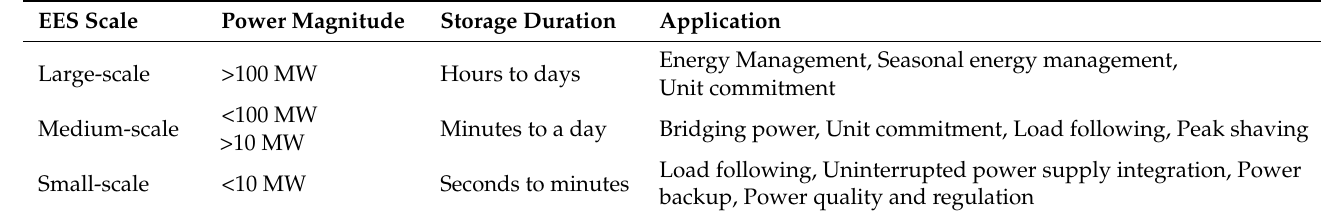
Table 2. Different types of EES in terms of output power capacity